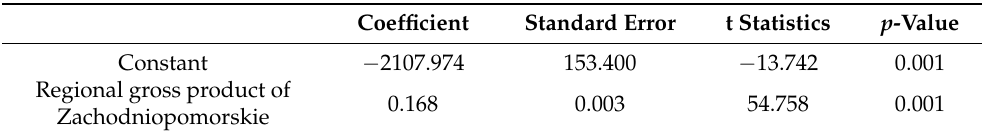
Table 4. Results of estimation of the model for revenue (dependent variable) and regional gross product (independent variable) of Zachodniopomorskie (model 9).